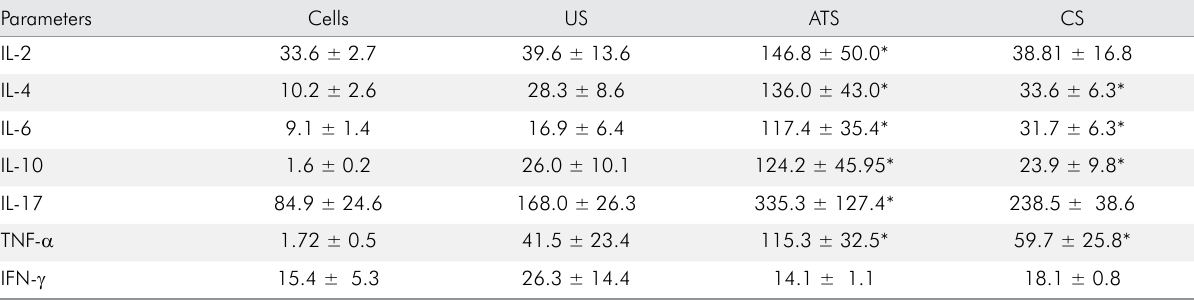
Table 1. Cytokine concentrations (pg/mL) in the culture supernatant of human blood MN cells. Cells on an untreated (acid-free) surface (US), cells on an acid-treated surface (ATS) and cells on cement-treated surfaces (CS). The results are expressed as the mean and standard deviation of 6 replicates with human blood cells from different